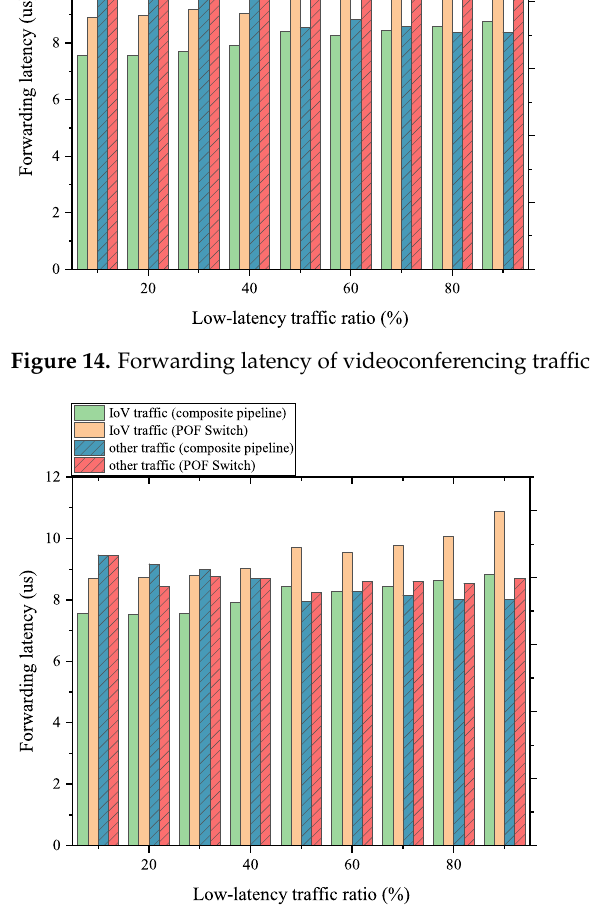
Figure 15. Forwarding latency of IoV traffic mixed with normal